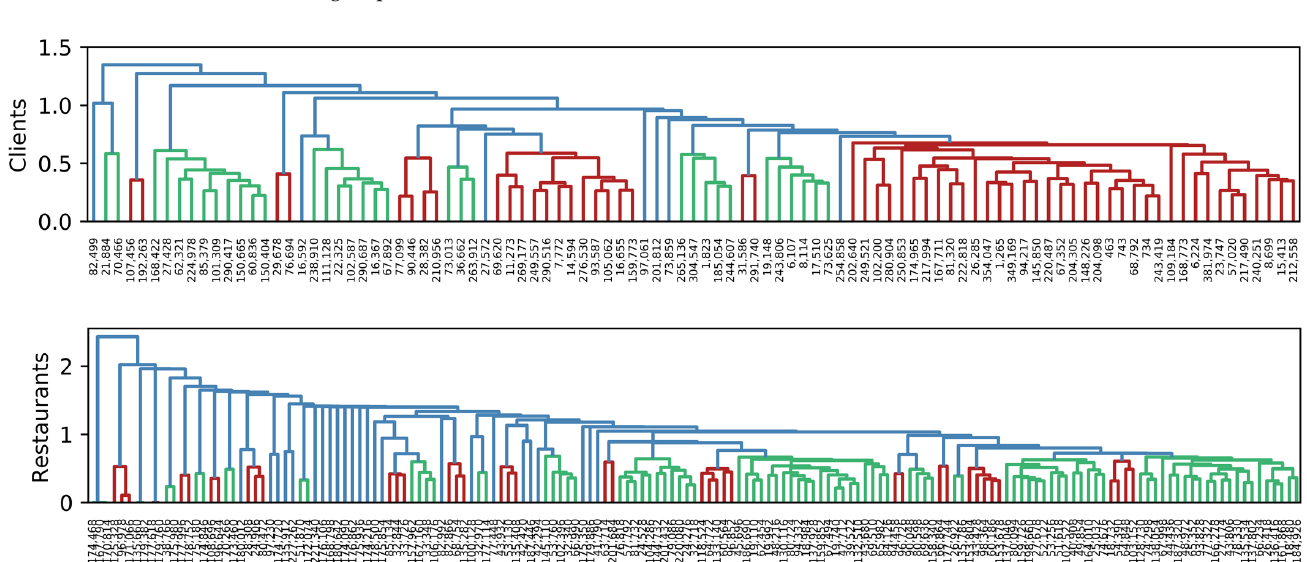
Figure 3. Similarity among clients and restaurants in 2019. The length of vertical lines represents the distance between items. The shorter the line, the closer the items. Different colors represent possible groups of items.